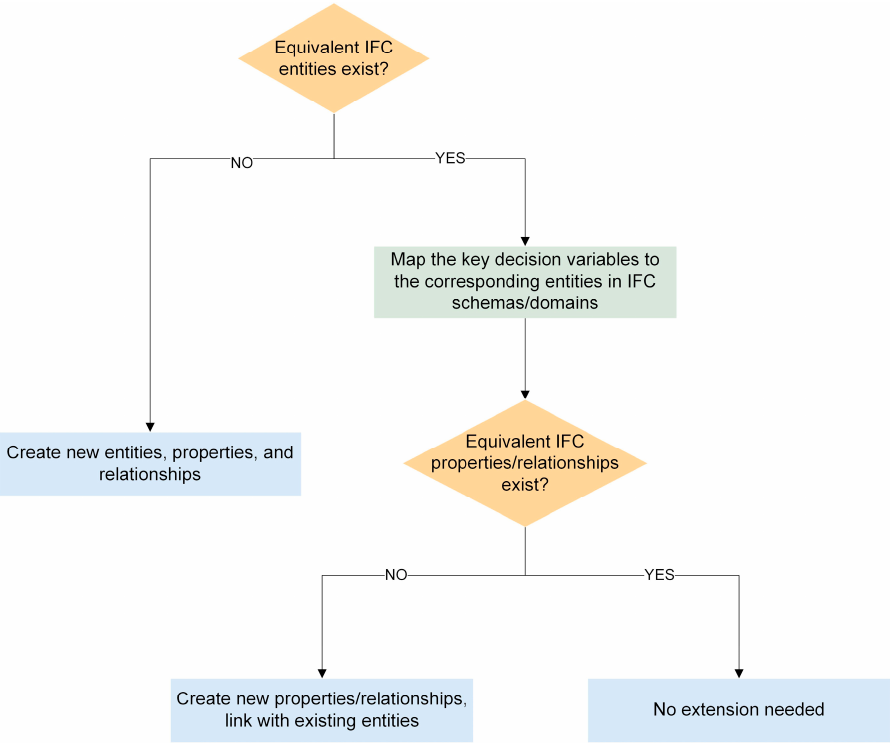
Figure 3. Mapping the identified key decision variables with the existing BIM/IFC schema.